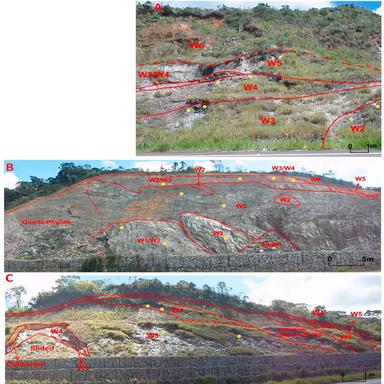
Compartmentalization of the phyllite weathering profiles Phy01 (a), Phy02 (b), and Phy03 (c). Yellow dots indicate the sample collection sites. (For interpretation of the references to color in this figure legend, the reader is referred to the Web version of this article.)